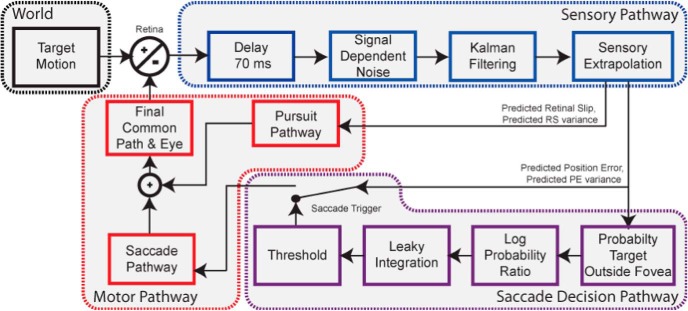
Saccade trigger model overview. A block diagram overview of the Bayesian decision model for saccade triggering. The sensory pathway estimates noisy signals from the world and extrapolates those to predict future errors. The decision pathway estimates confidence in future error prediction and triggers a saccade for a certain confidence threshold. The motor pathway adds the pursuit and saccade motor commands. Adapted with permission from Coutinho et al. (2018).